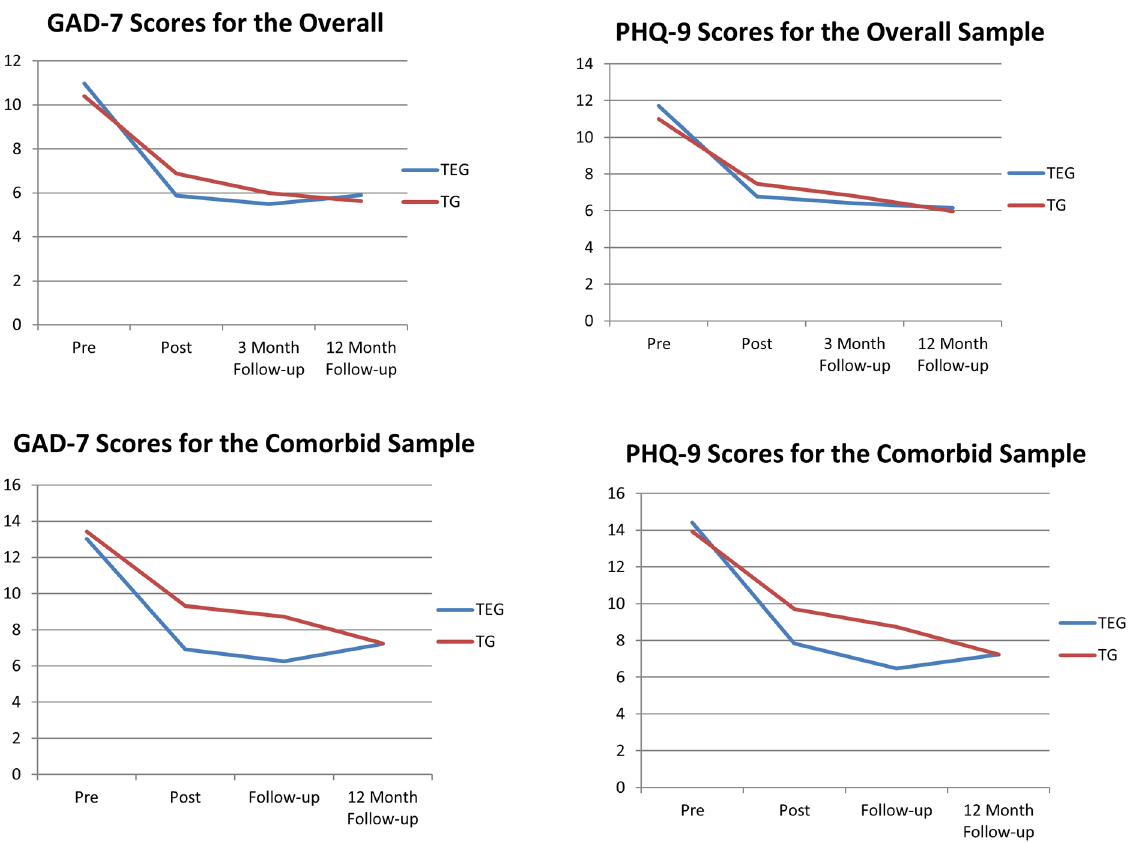
Figure 1. Means for the PHQ-9 and GAD-7 for the Overall and Comorbid Samples. Note: TEG: Treatment plus automated email group. TG: Treatment group. PHQ-9: Patient Health Questionnaire-9 Item. GAD-7: Generalised Anxiety Disorder-7 Item.